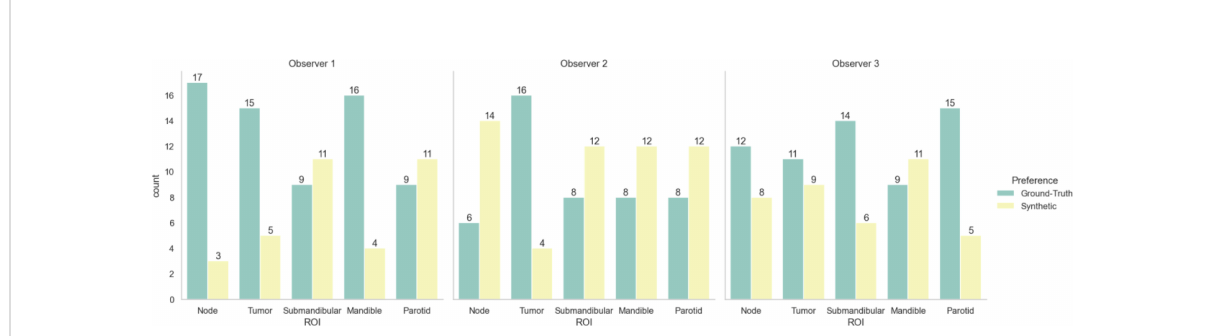
FIGURE 5 Clinician image preferences strati fi ed by region represented in the presented image slice. Green bars correspond to ground-truth 6-minute MRI slices, while yellow bars correspond to synthetic 6-minute MRI slices.